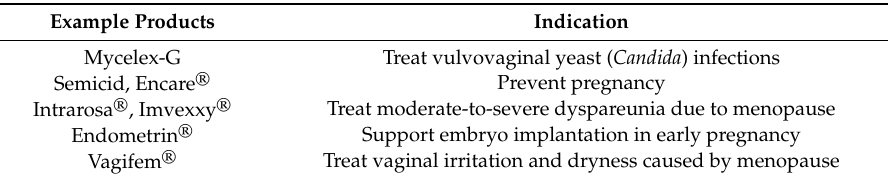
Table 1. Examples of FDA approved topical inserts.